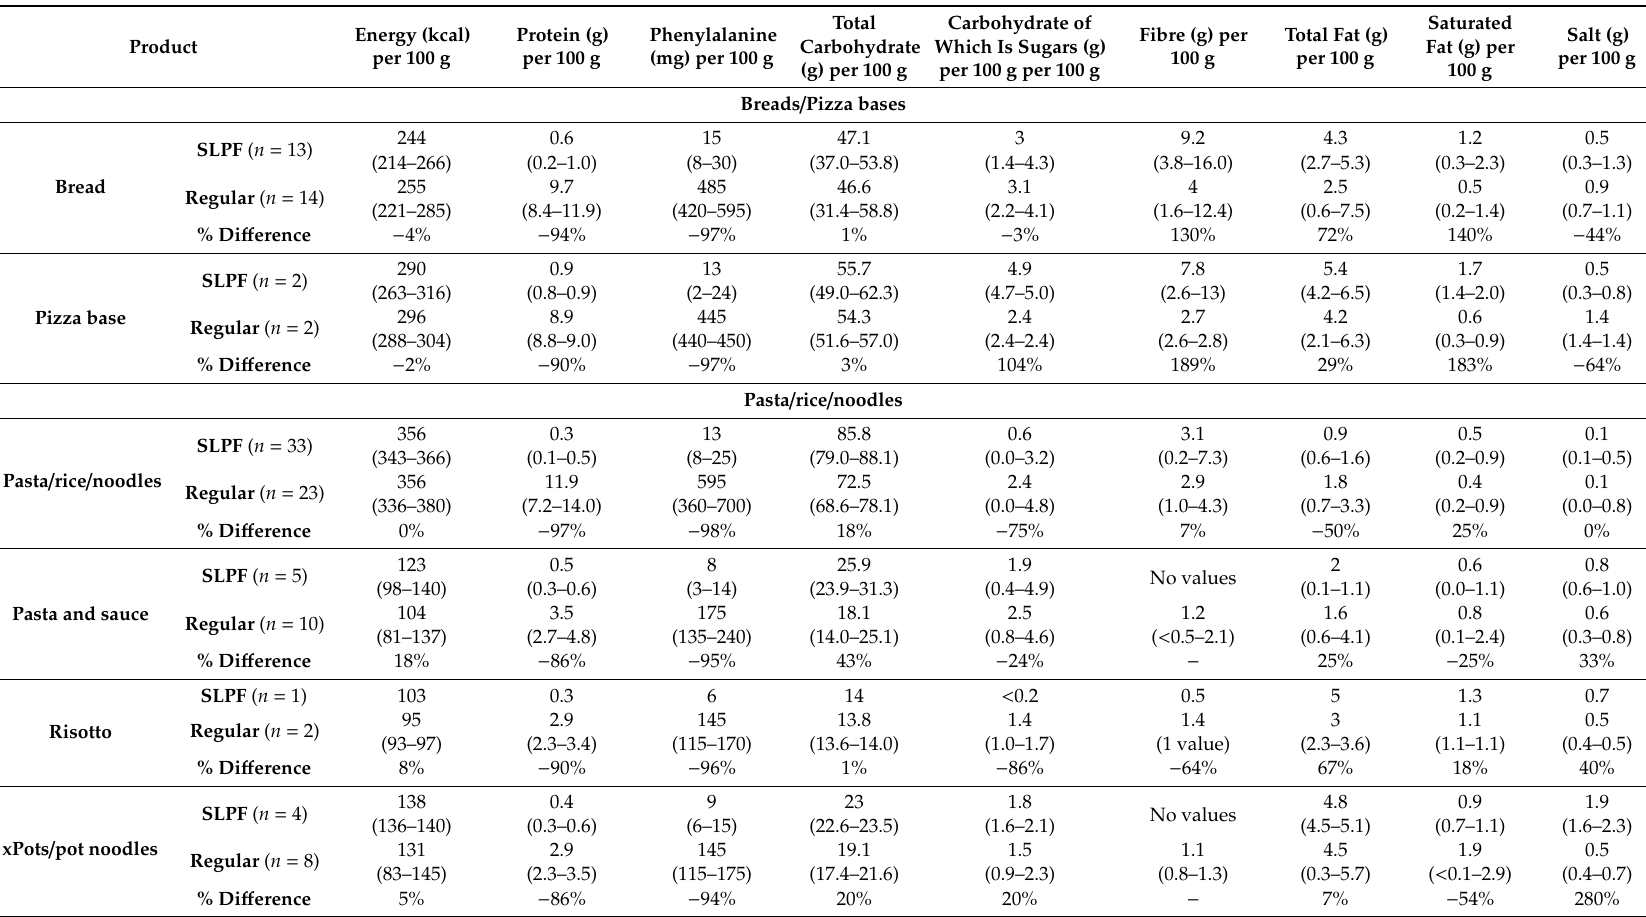
Table A1. Nutritional composition data for all low protein and regular subgroups analysed per 100 g of product. Values displayed as Mean